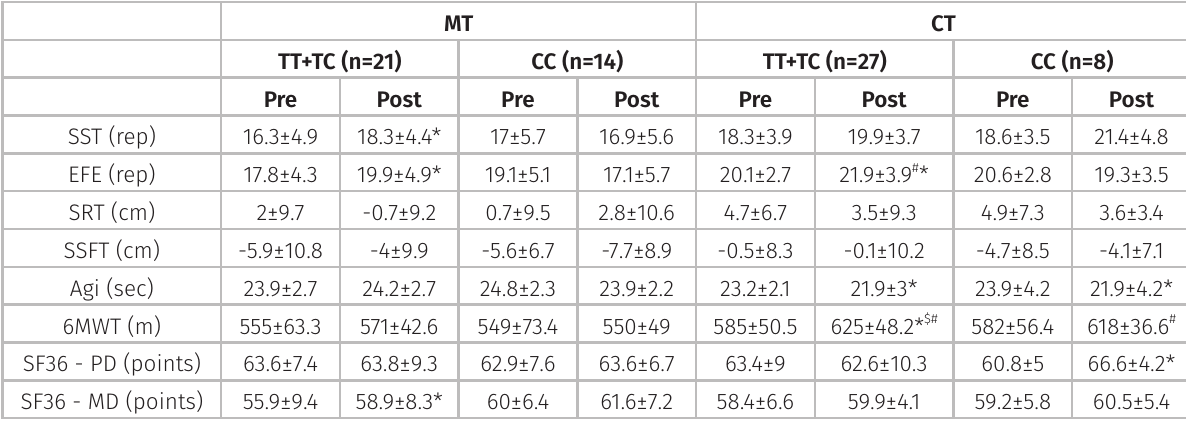
Table VI. Physical capacities and quality of life of MT and CT groups related to ACE